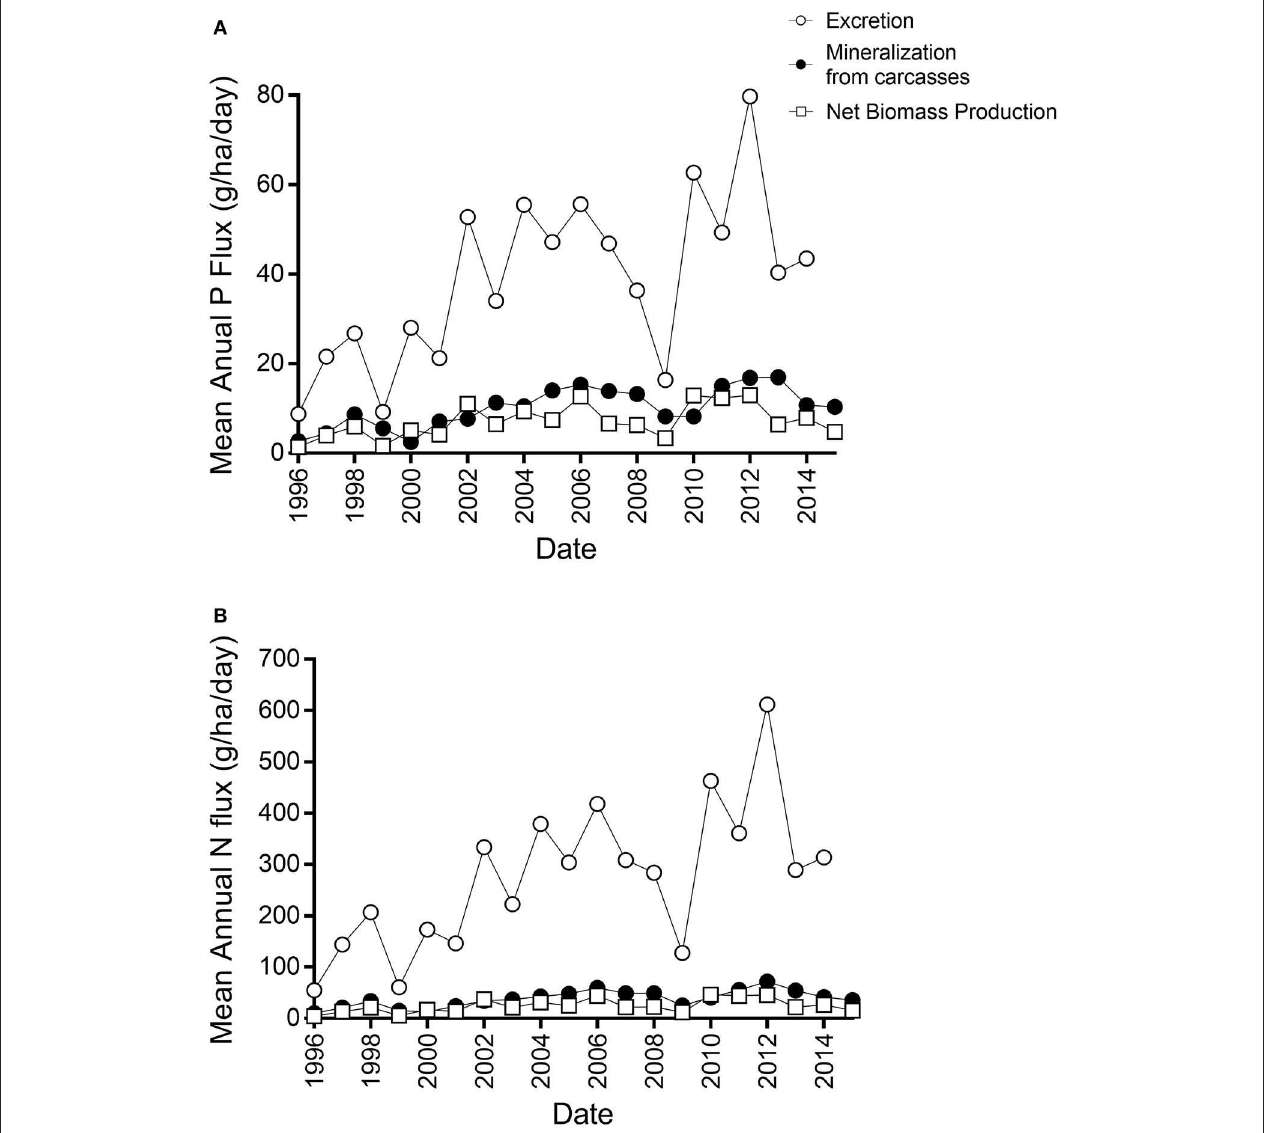
FIGURE 5 | Annual fluxes of phosphorus (A) and nitrogen (B) for net biomass production (white square), carcass remineralization (black dots), and excretion (white